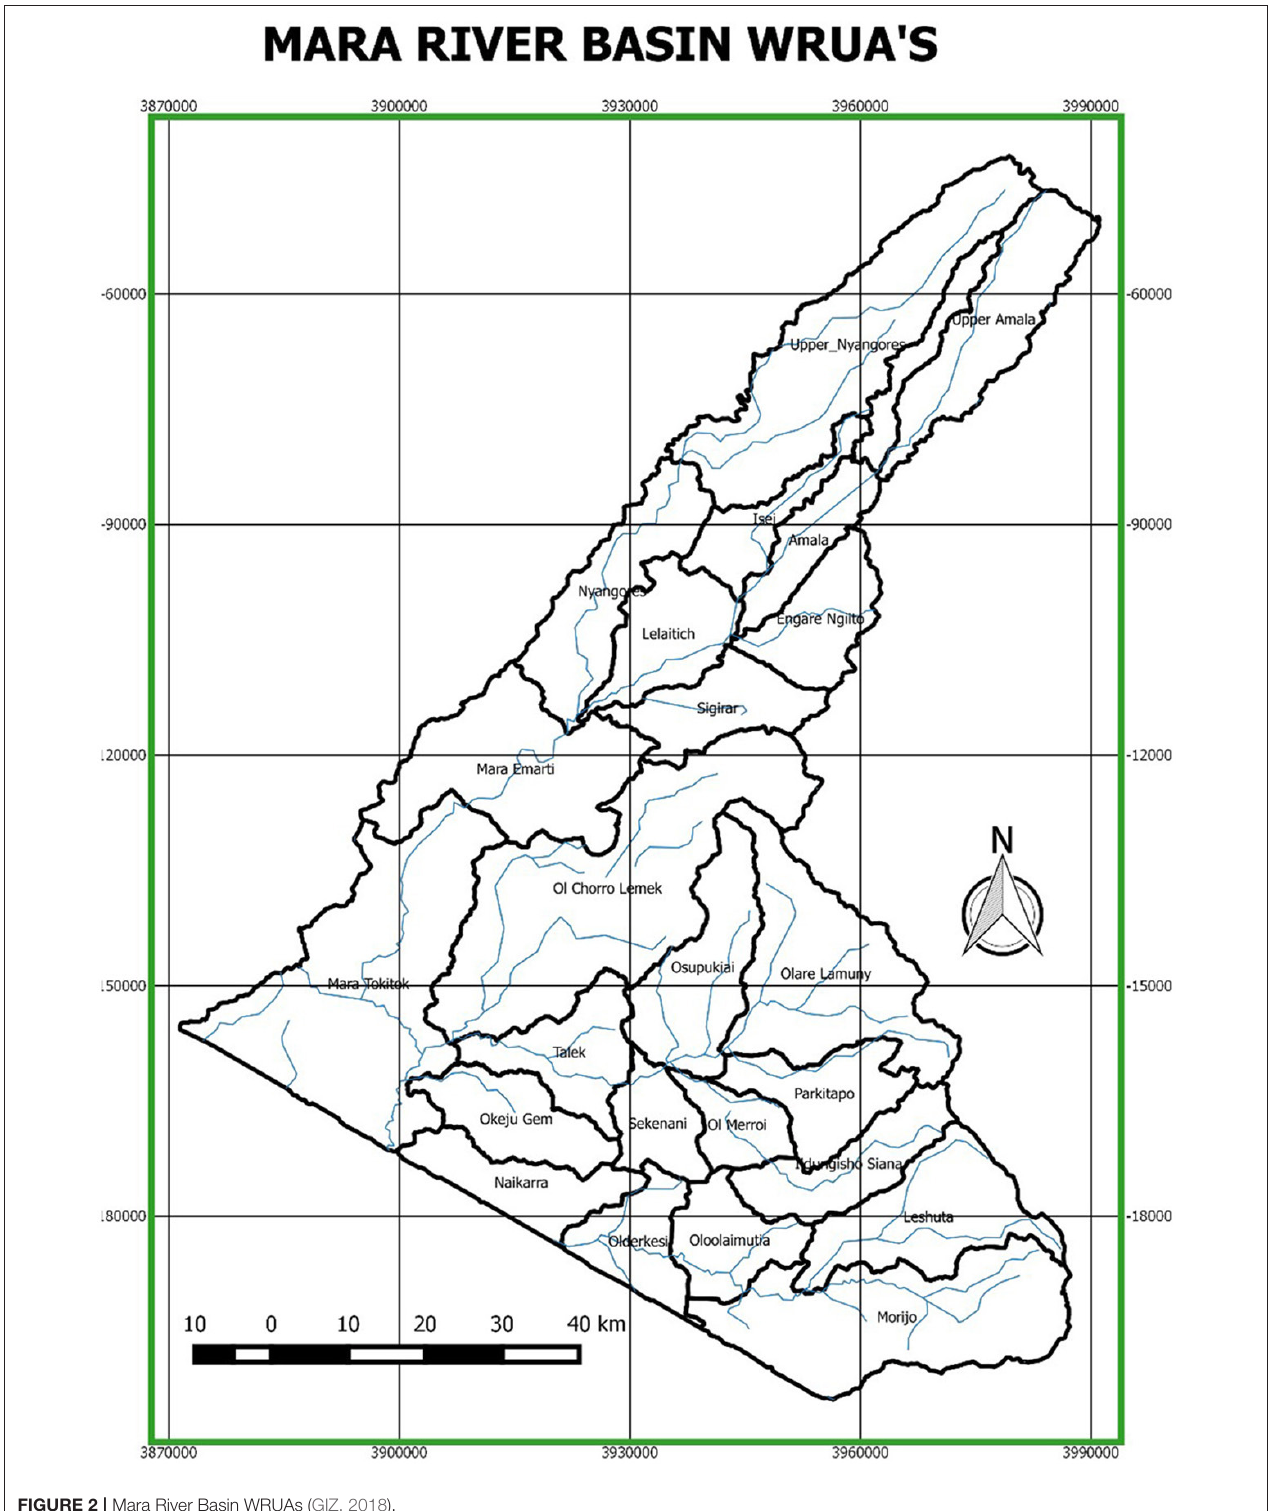
FIGURE 2 | Mara River Basin WRUAs (GIZ, 2018).